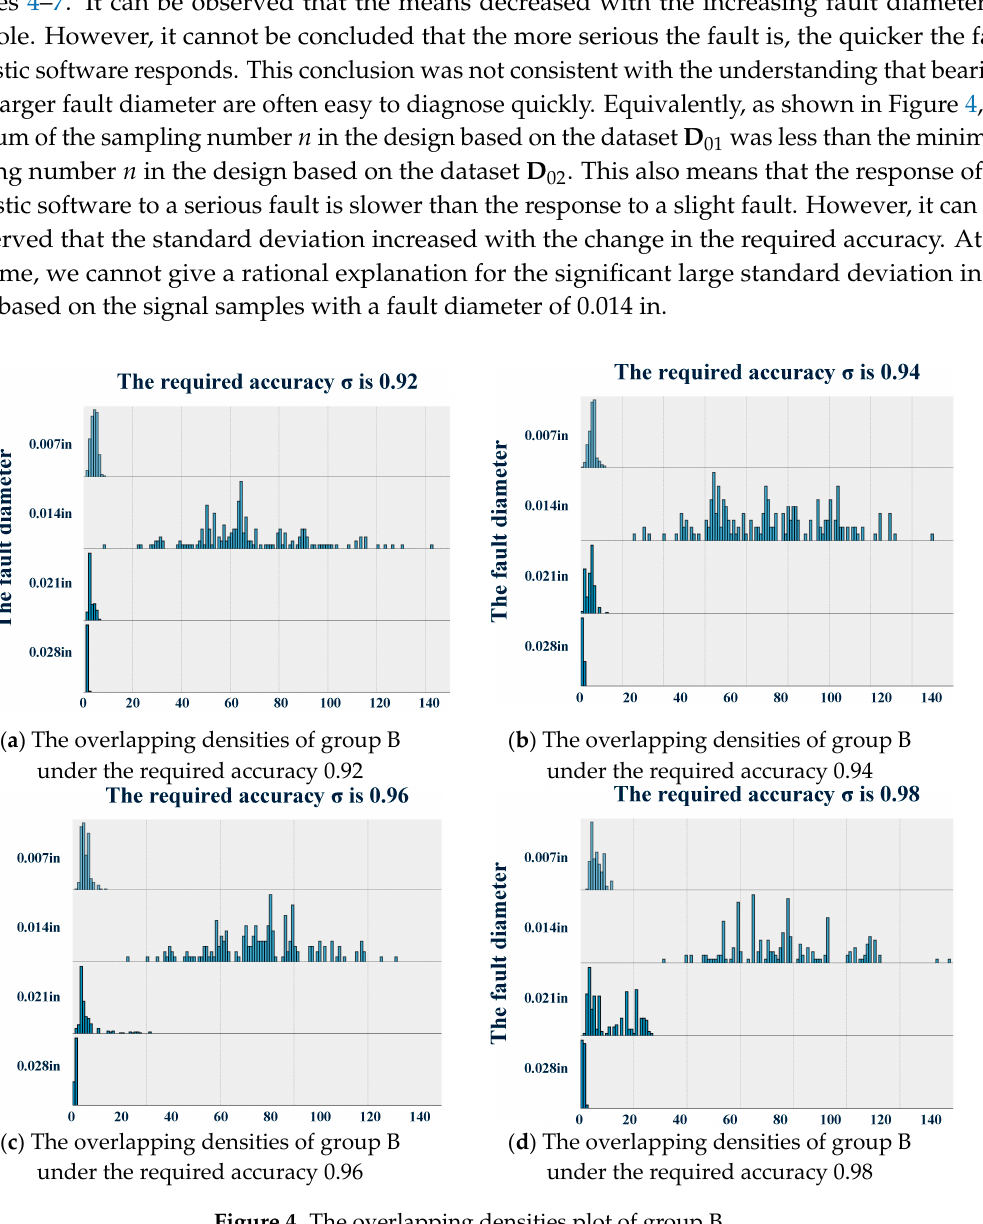
Figure 4. The overlapping densities plot of group B. Table 4. The standard deviation of the sampling number in group B.